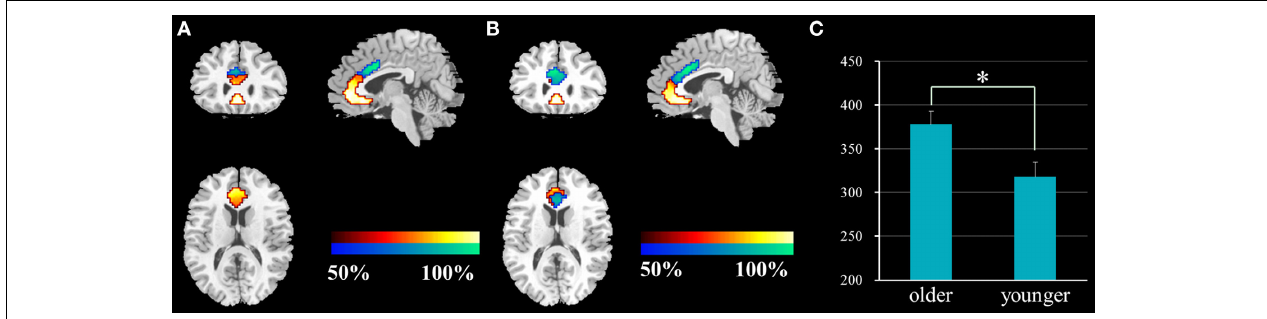
FIGURE 1 | Results of the functional parcellation analysis of ACC [rACC (red-yellow color gradient) and dACC (blue-green color gradient)] in younger adults (A) and older adults (B). Significant